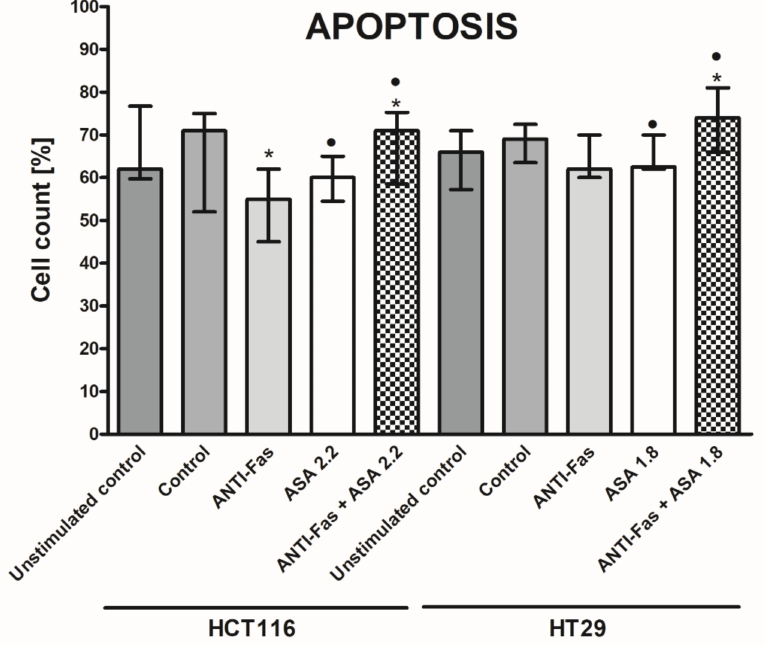
Figure 4. The cytometric analysis of cells’ apoptosis during 10 day–expansion of HCT116 and HT29 cells in spherical forms with agonistic anti-Fas antibody (200 ng/mL), isotype control IgM Ab and/or aspirin (ASA) (2.2 mM or 1.8 mM for HCT116 or HT29, respectively). Annexin V– FITC/PI were used for assessing apoptotic cells. Y-axis presents Annexin V + PI cells frequency (%). Statistically significant differences were assessed by Kruskal-Wallis test followed by Dunn’s test as a post hoc procedure. Bars and whiskers represent median ± interquartile range (* p < 0.05 vs